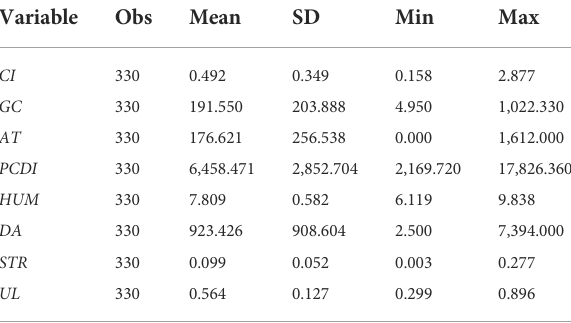
TABLE 3 Descriptive statistics results.